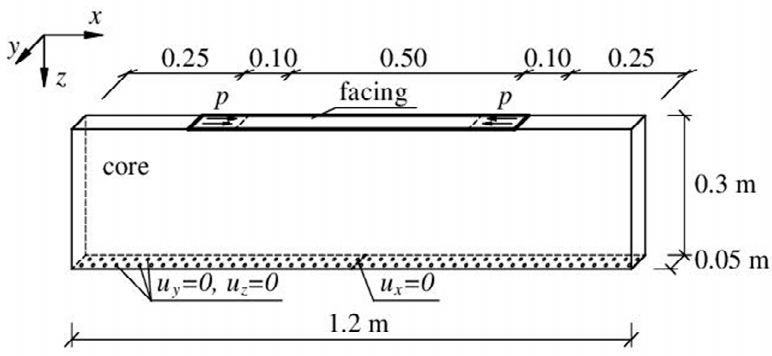
Figure 5. Numerical model of the problem of compression of a thin facing resting on a susceptible substructure.